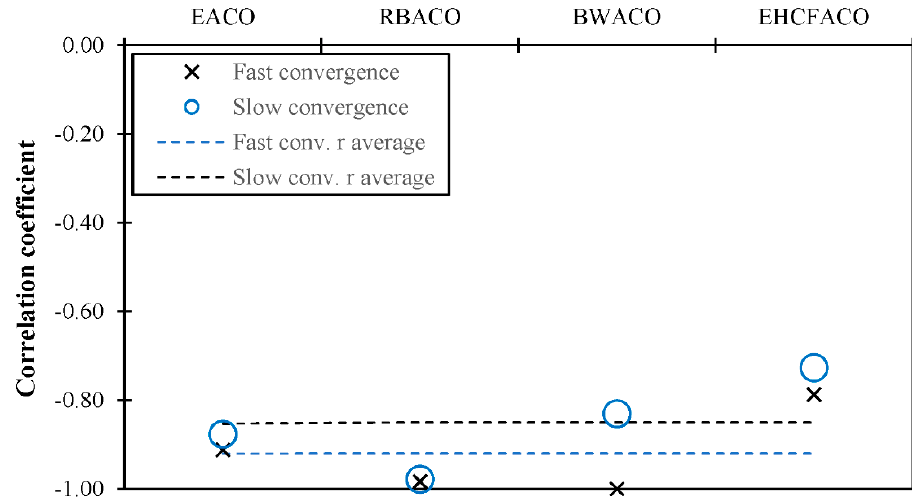
Figure 8. Correlation coefficient of EACO, RBACO, BWACO, and EHCFACO algorithms.